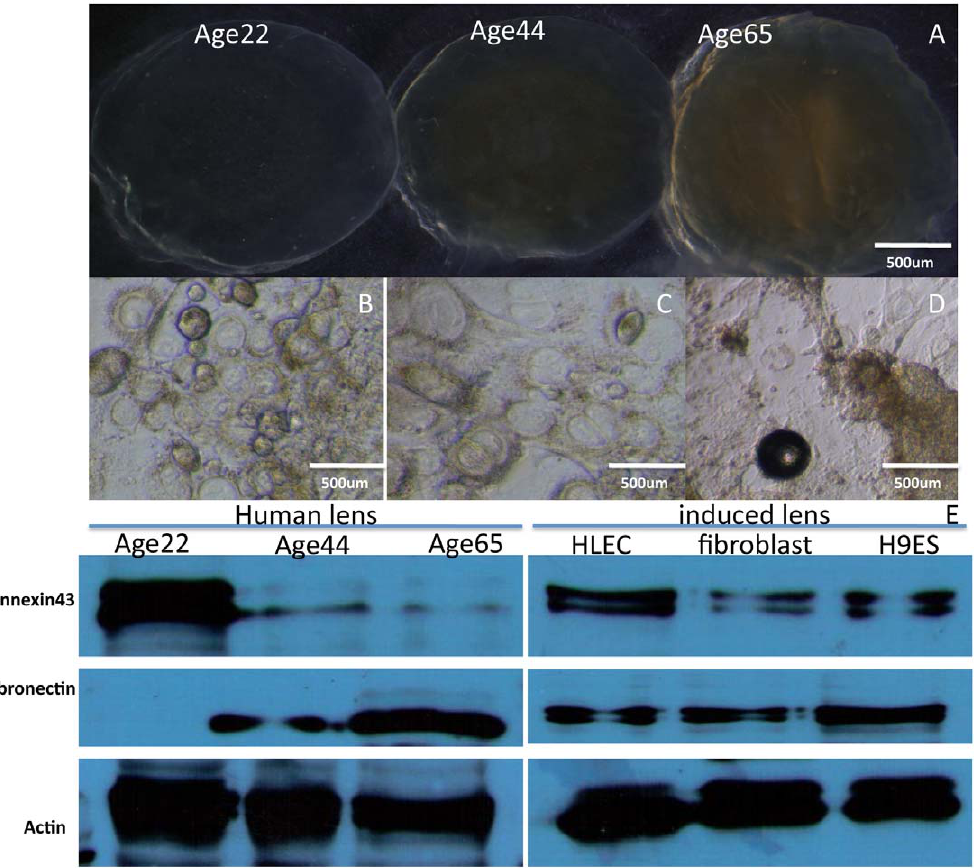
Figure 6. HLEC-derived lens cells exhibit characteristics of young lens cells with reduced EMT. Human lenses at different ages are shown in Fig. 6A, and the morphology of the induced lenses are shown in Fig. 6B–D: (B) the HLEC-iPS-derived lens, (C) human fibroblast-derived lens, (D) h9ES cell line-derived lens. The expression of EMT markers was revealed by western blot. Connexin-43 was abundantly expressed in younger lens cells and HLEC-derived lens cells, while it was significantly suppressed in older lens, skin fibroblast and ES-derived lens cells. In contrast, the expression of fibronectin was significantly increased in older lens, fibroblast and ES-derived lens cells (Fig. 6E).